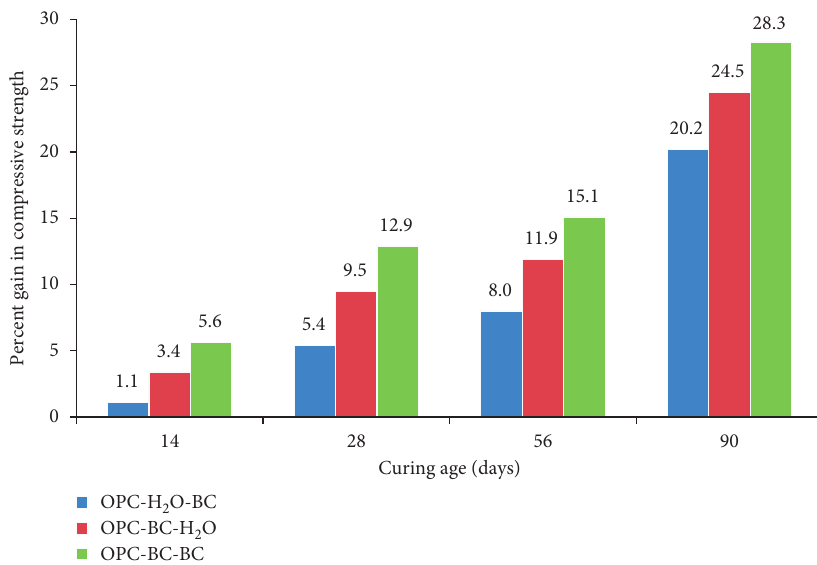
Figure 2: Results for percentage gain in compressive strength for different curing periods.